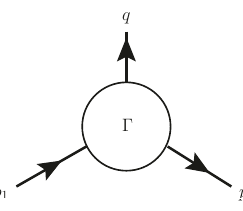
Figure 18 . Kinematics used for the correlators of fermion bilinears. Here we have (cid:0) = A = (cid:13) (cid:22) (cid:13) 5